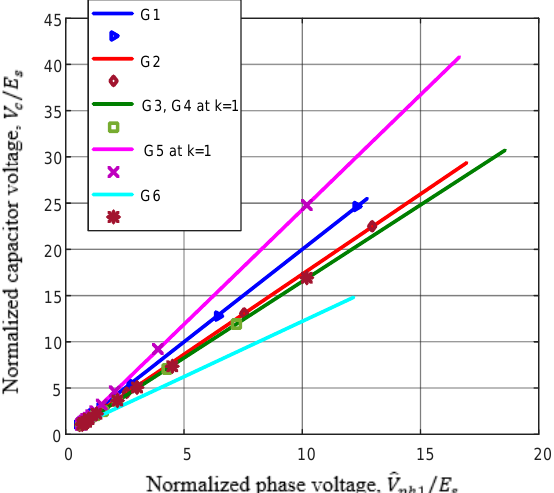
Figure 19. The relation between capacitor voltage and normalized phase voltage, solid lines: theoretical results, marks: simulation results.